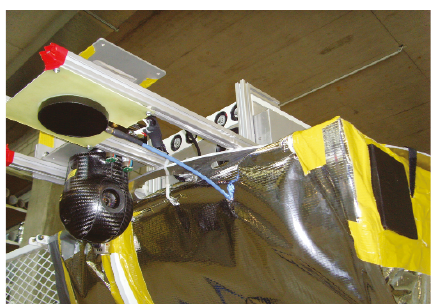
Figure 10: Payload components for first airborne